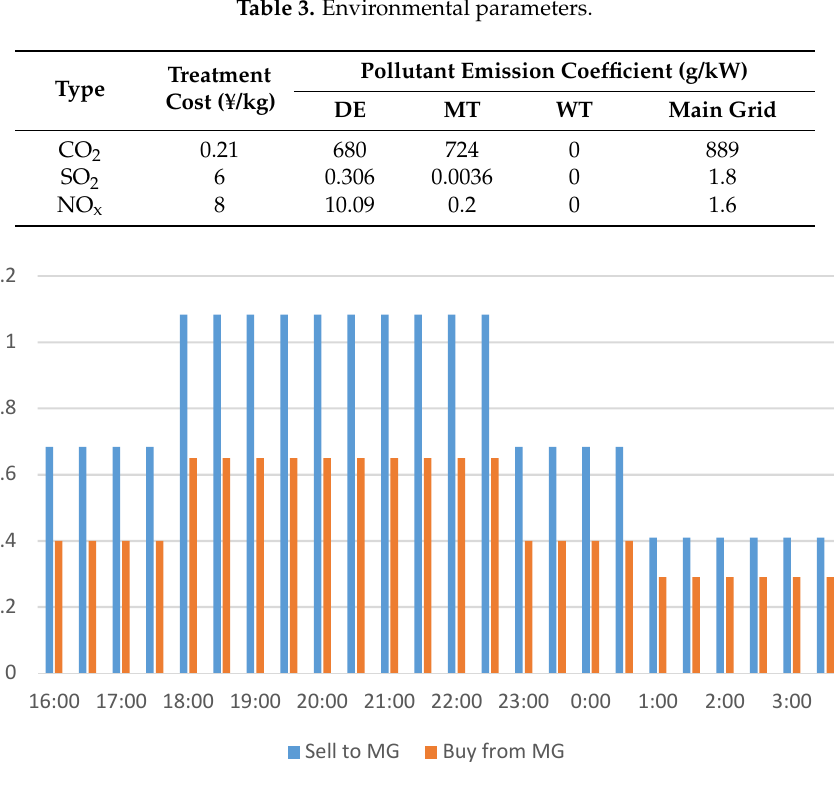
Figure 4. Time-of-use electricity price. Table 2. Operation and maintenance coefficients of distributed generations (DGs).